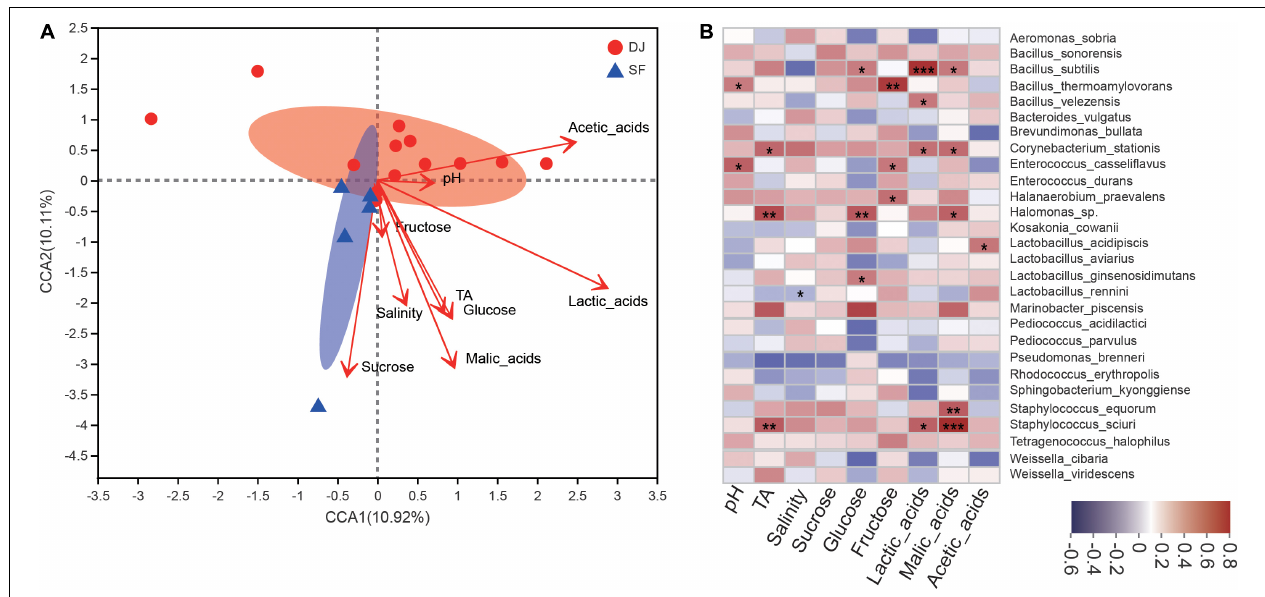
FIGURE 7 | Correlational analyses. (A) Canonical correlation analysis (CCA) of the Dajiang and Sufu bacterial communities. (B) Heatmap of Spearman correlations between microbiota and physicochemical characteristics at the species level in different fermented soybean products. R values represent positive (red) or negative (blue) correlations. * P < 0.05, ** P < 0.01, *** P < 0.001.